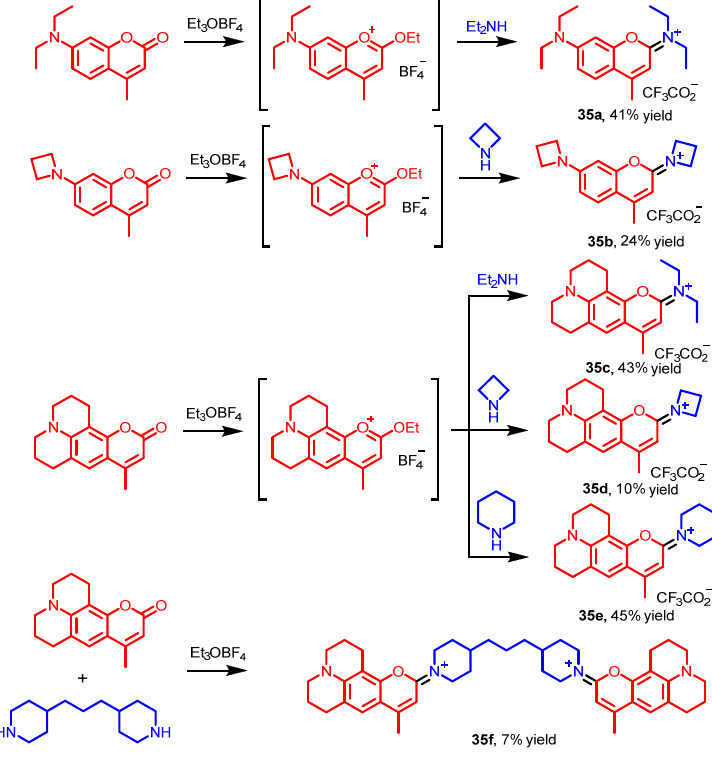
Scheme 28. Synthesis of dyes 35a – f .